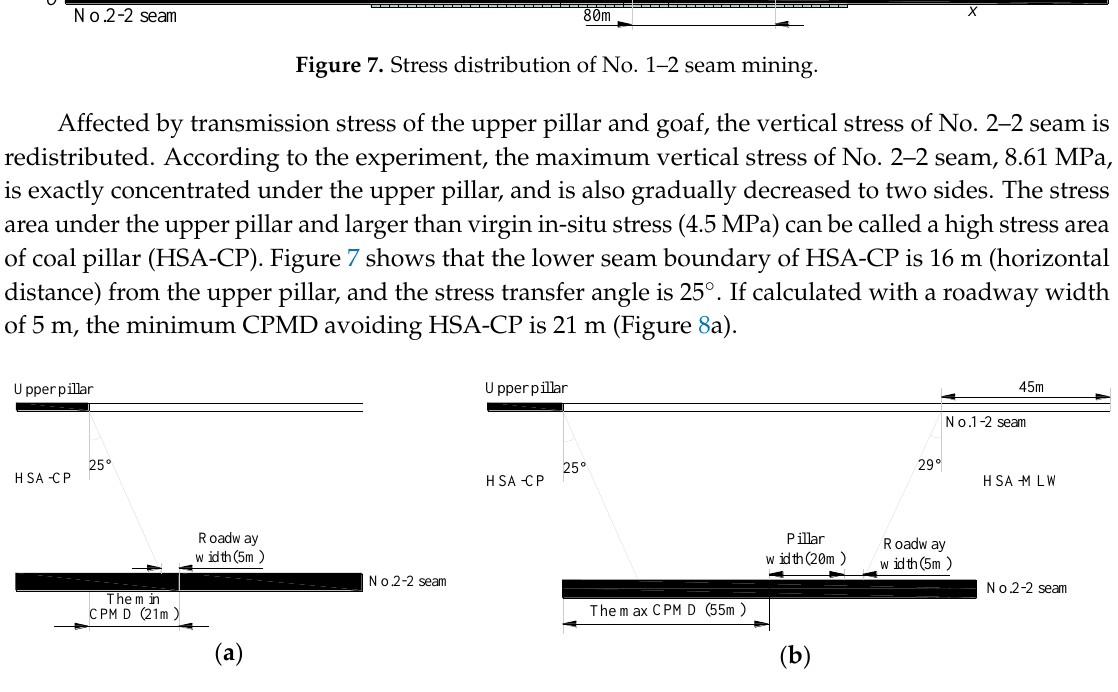
Figure 7. Stress distribution of No. 1 – 2 seam mining.